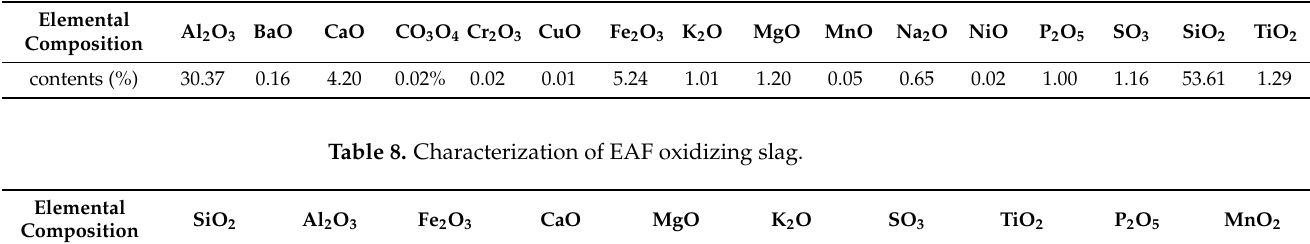
Table 7. Characterization of fly − ash.